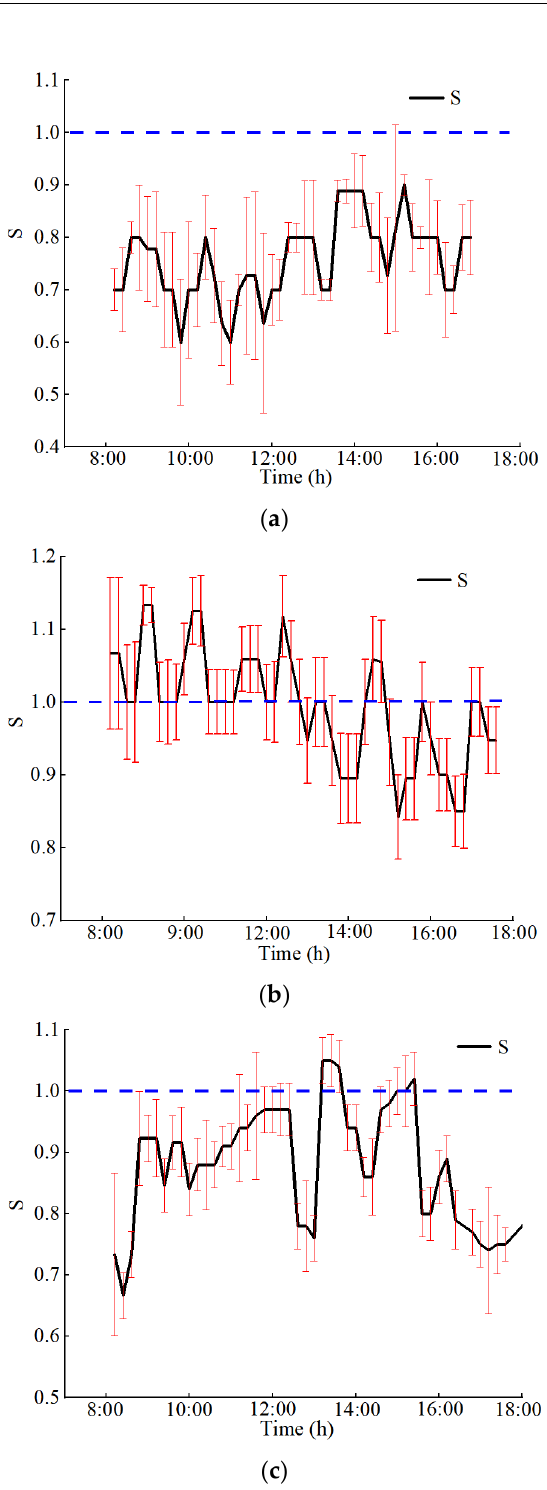
Figure 11. S range for the ( a ) LH, ( b ) HL, and ( c ) MM operating strategies.